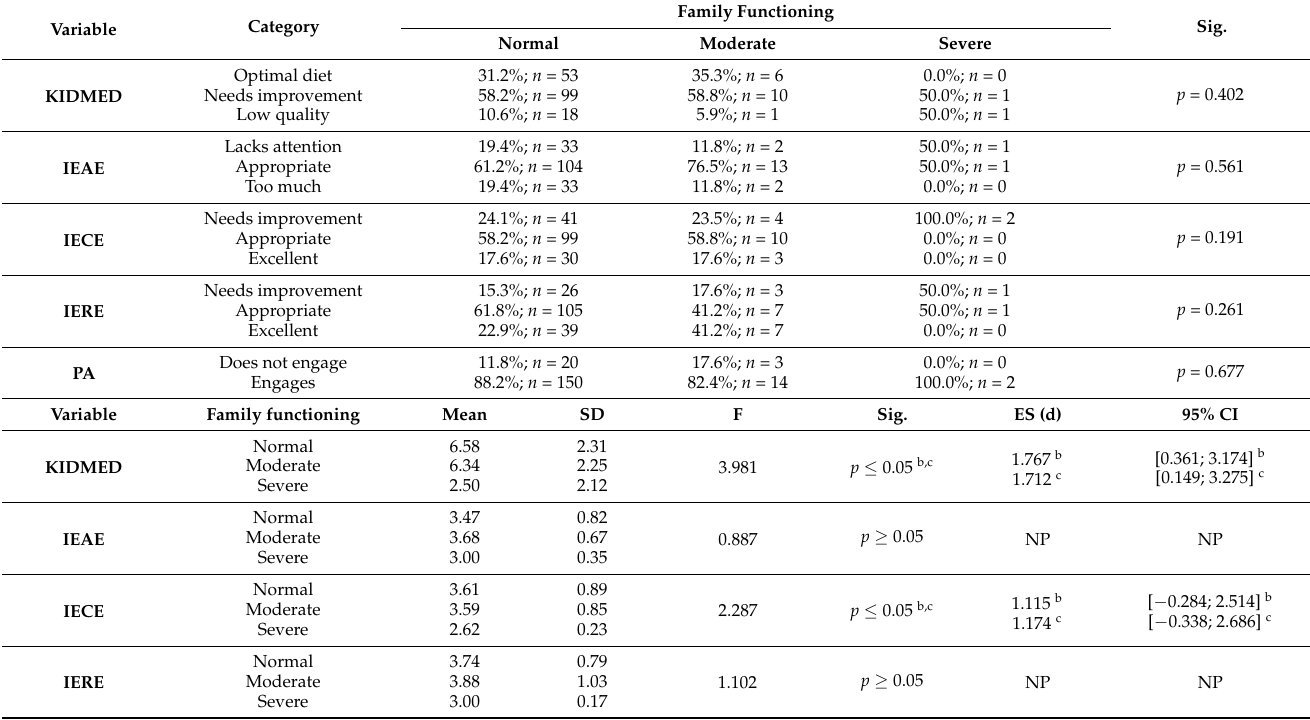
Table 3. Relational analysis of the variable describing family